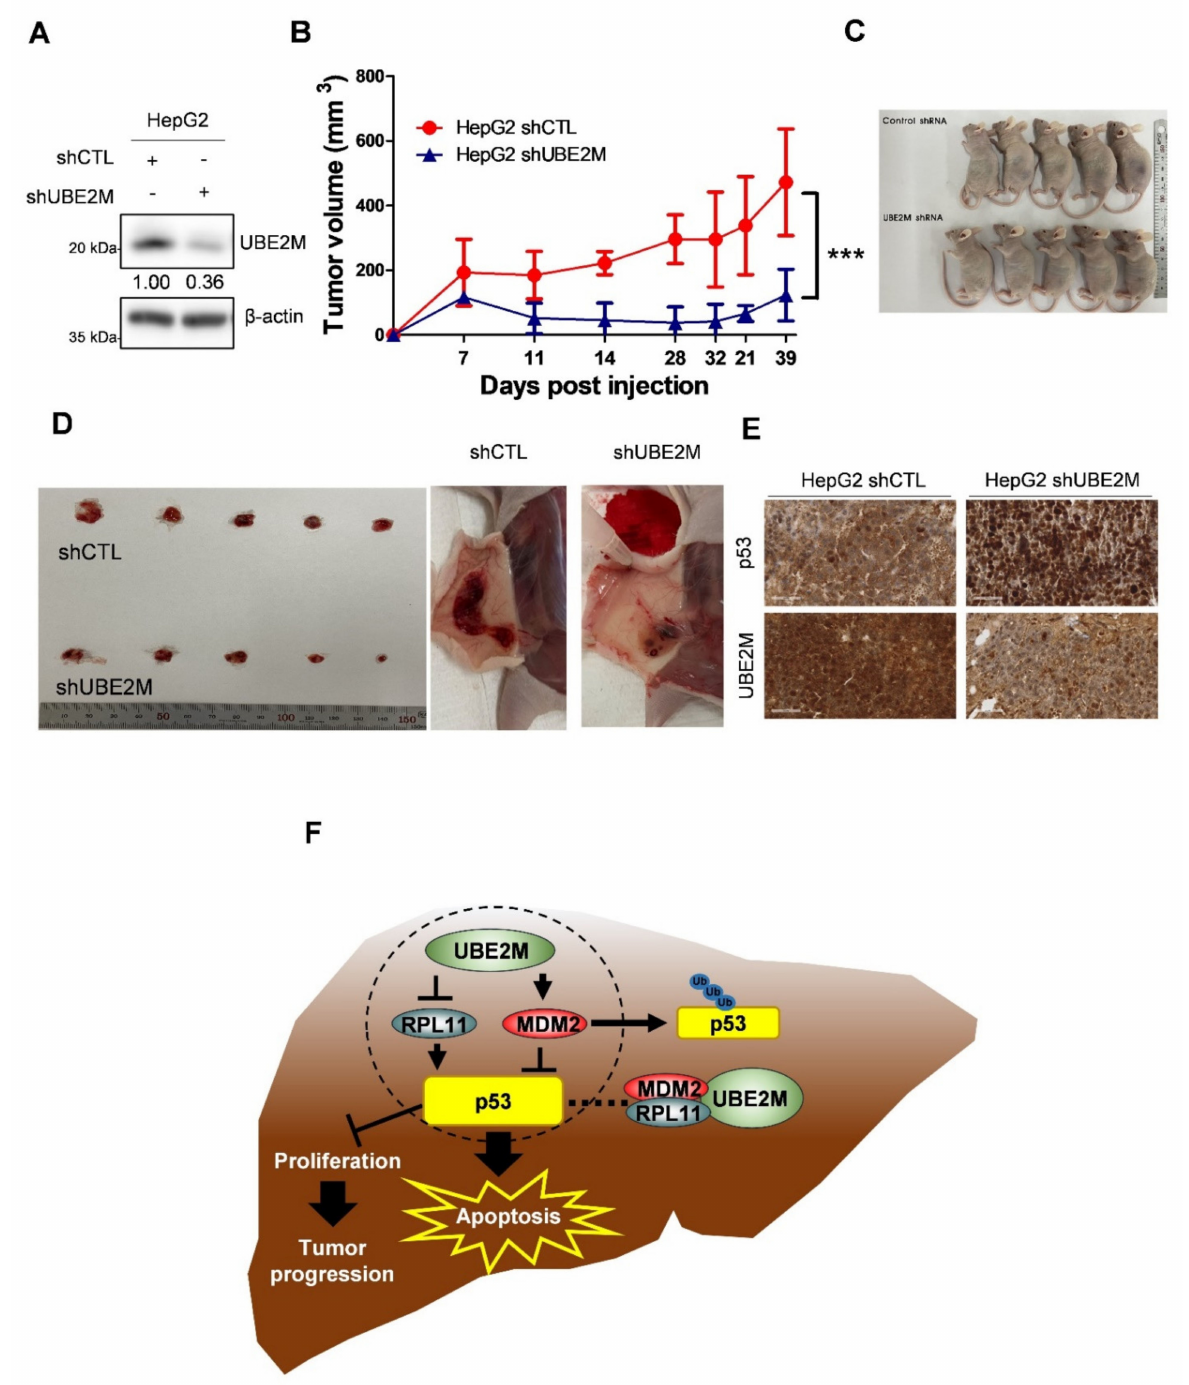
Figure 7. UBE2M knockdown retards the growth of HepG2 cells implanted in Balb/c. ( A ) HepG2 cells transfected with UBE2M shRNA were stabilized and selectively proliferated by puromycin; UBE2M expression level was confirmed by immunoblotting. ( B ) The cells were subcutaneously injected in the flank of Balb/c nude mouse. The tumor size was monitored and measured with the length and width of the tumor for 39 days with a caliper. ( C , D ) Thirty-nine days after injection of UBE2M shRNA transfected HepG2 cells, mice and isolated tumors were photographed. ( E ) The tumors were fixed and paraffinized for making blocks and then IHC was conducted with antibodies of p53 and UBE2M. × 40 magnification. ( F ) The schematic diagram of UBE2M signaling associated with MDM2, p53 and RPL11. *** p < 0.001 vs. HepG2